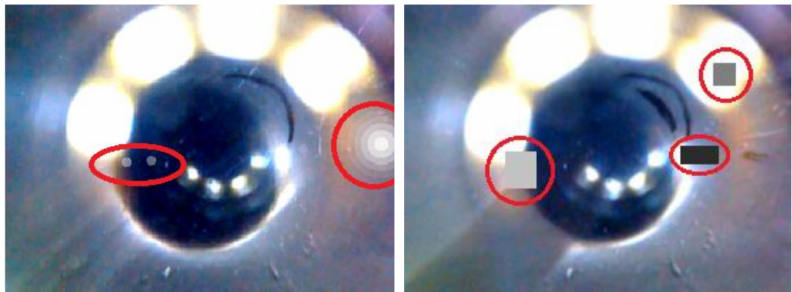
Figure 4. Examples for the data augmentation techniques used in this work (highlighted by red circles). ( Left ) RandomSunFlare as provided by the albumentations library with settings adjusted to fit our needs. ( Right ) Modified version of cutout data augmentation technique to coarsely simulate additional lights and